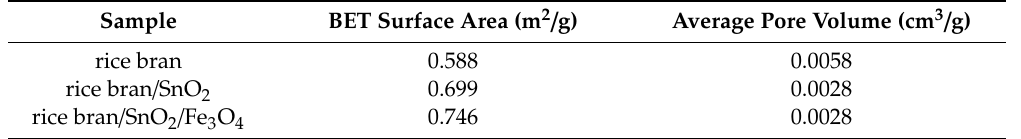
Table 2. Brunauer–Emmett–Teller (BET) surface area of the